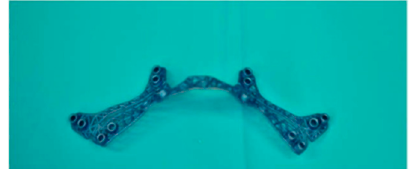
Figure 4. Cutting guide for the upper jaw.